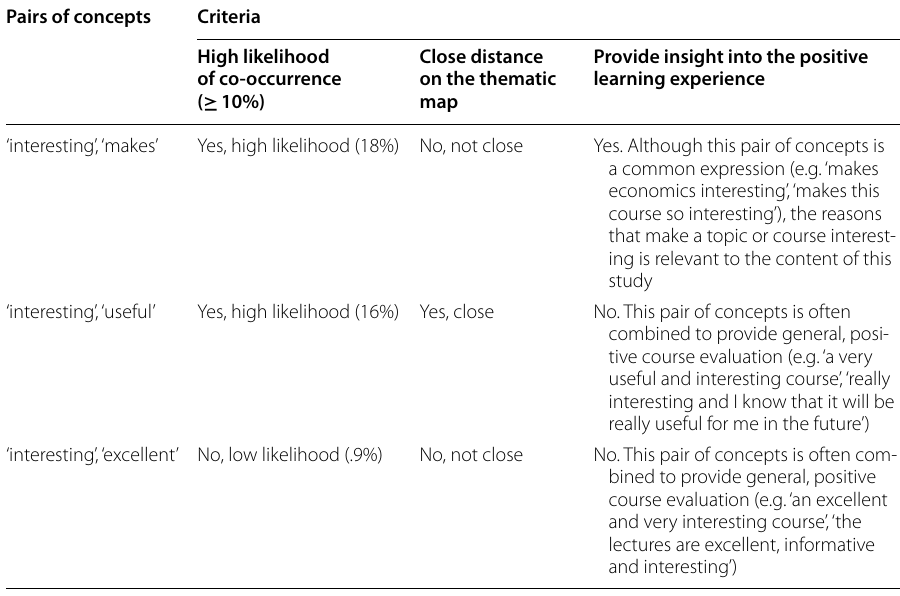
Table 3 Examples of pairs of concepts not qualified as important connections Pairs of concepts